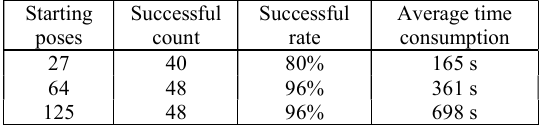
Table 3. Initialization validation